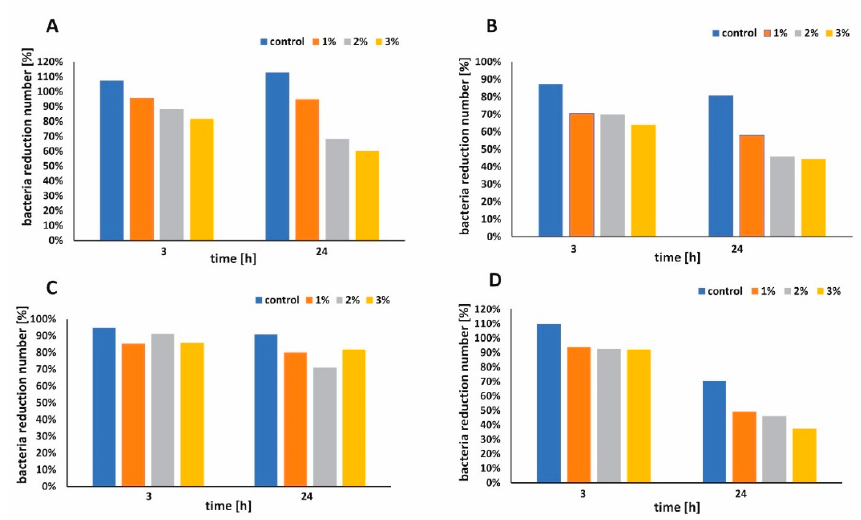
Figure 7. The antibacterial performance of functionalized 1, 2, and 3% h-BN-OH paper and control sample examined for varied bacterial suspension volumes: E. coli 275 mL ( A ), E. coli 55 mL ( B ), S. epidermidis 275 mL ( C ), and S. epidermidis 55 mL ( D ), after 3 and 24 h.